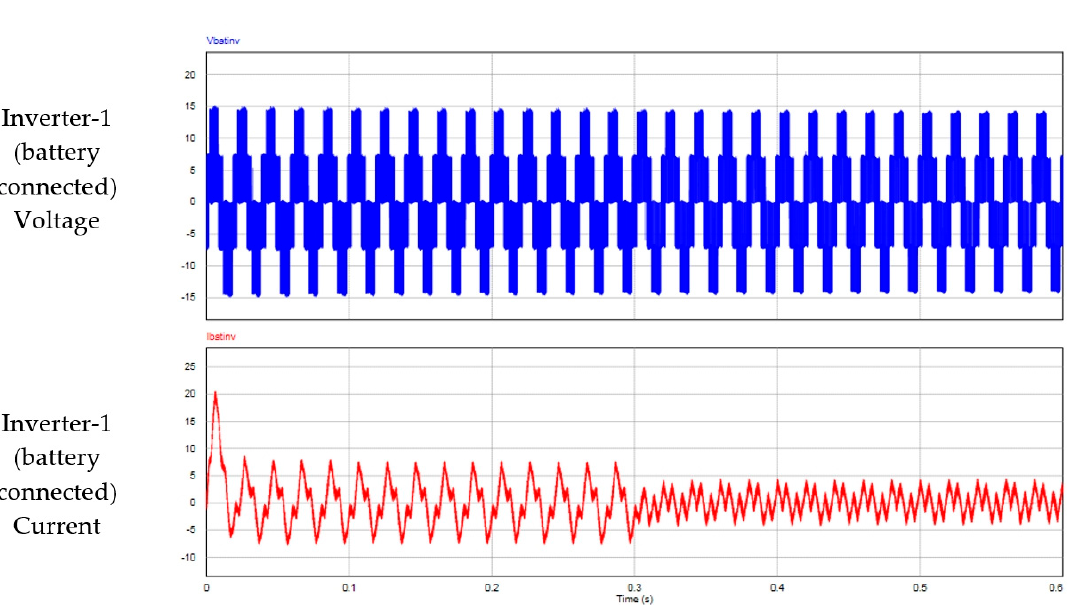
Figure 16. For mode-1: active and reactive power consumed.